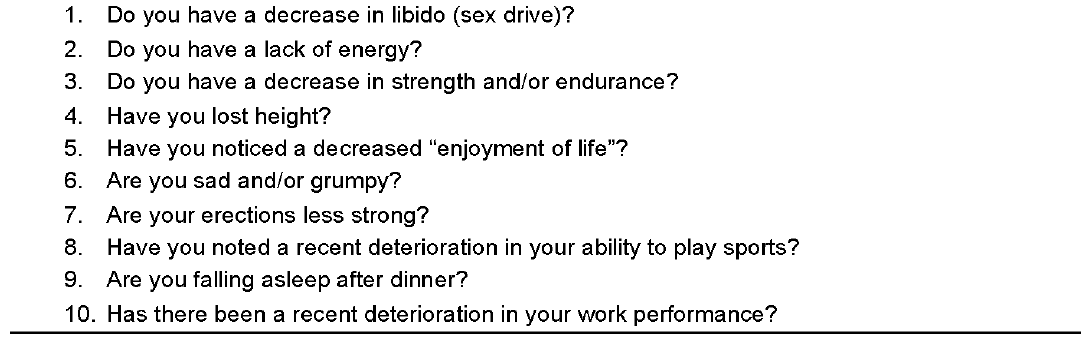
Figure 1. Androgen Deficiency in the Aging Male Questionnaire (ADAM). This non-invasive screening tool was administered to all participants to assess androgen deficiency.